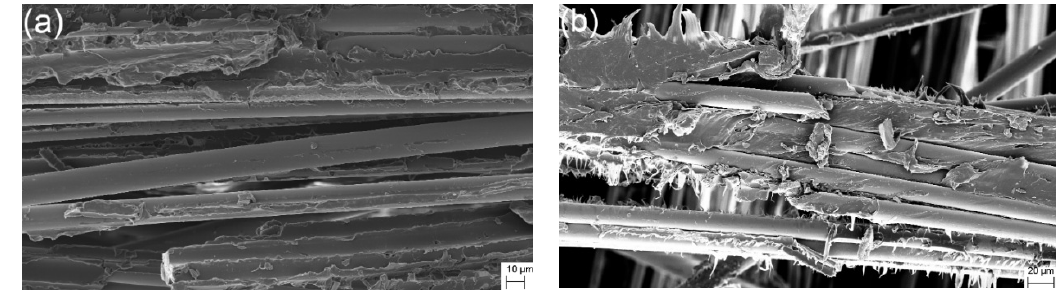
Figure 4. The fracture surface of 90° off ‐ axis samples: ( a ) quasi ‐ static loading and ( b ) creep loading.